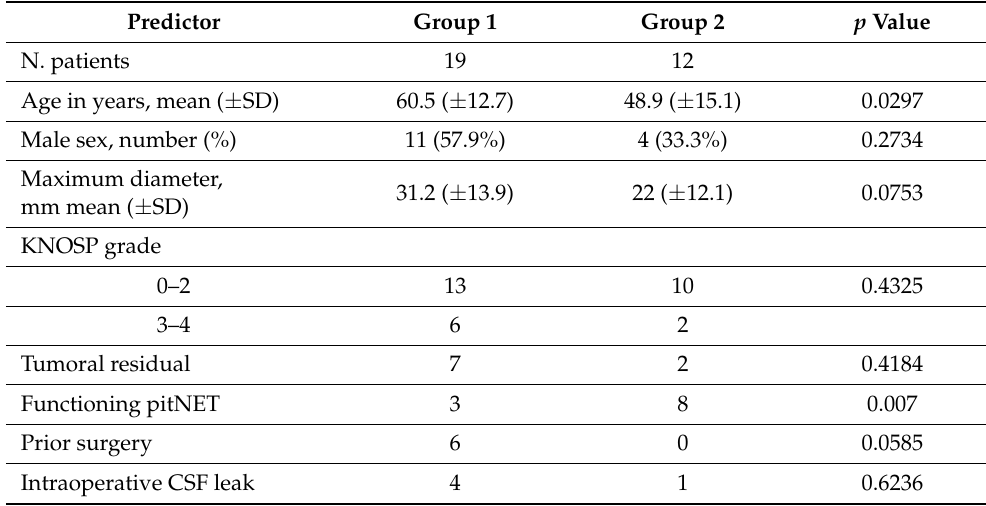
Table 3. Predictors of gland recovery following transsphenoidal surgery. p values < 0.05 are shown in bold.